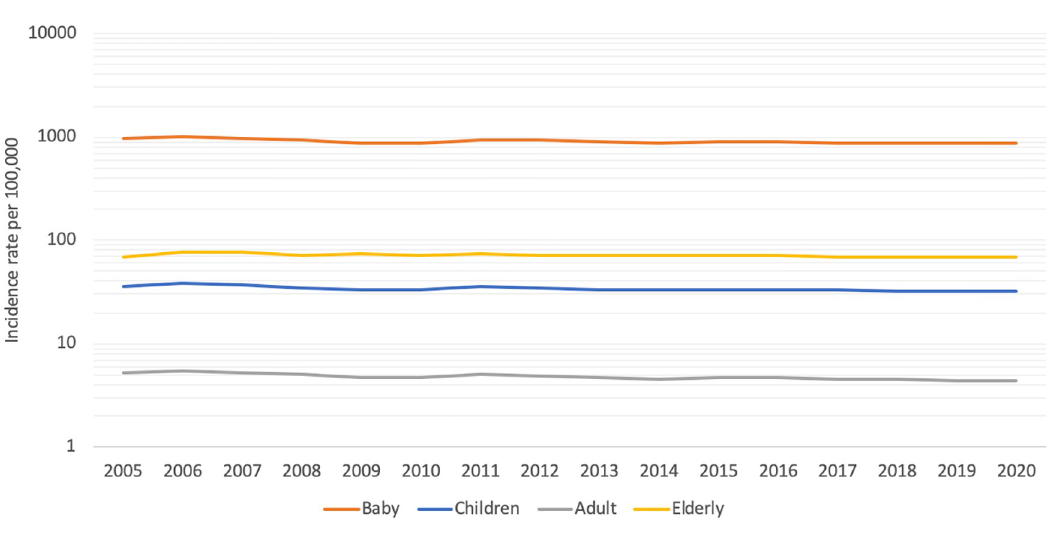
Fig 4. Projection of RSV incidence (logarithmic scale) for each household between 2005 and 2020 in Thai rural setting: Baby (orange color), children (blue color), adult (gray color), and elderly people (yellow color).